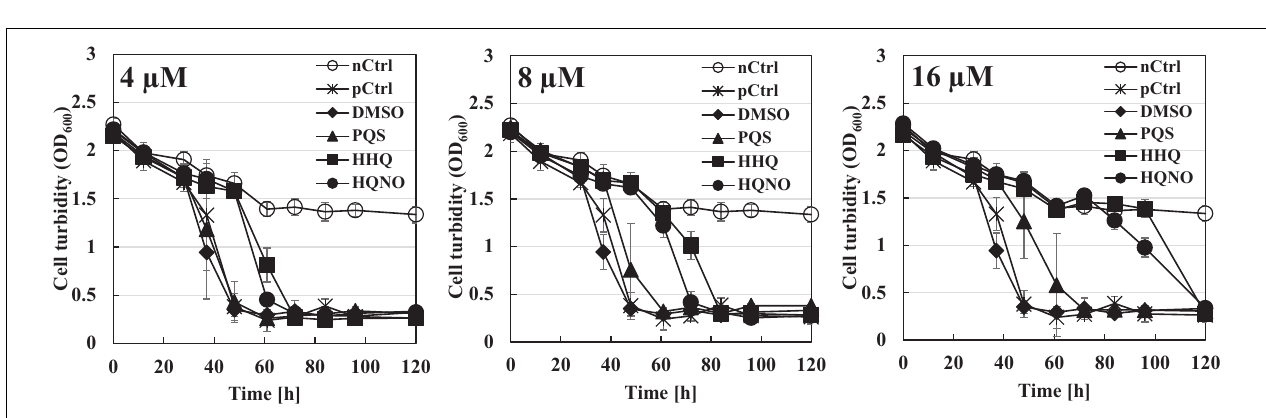
FIGURE 4 | Effect of each quinolone compound itself on the predation liquid assays using a mixture of Bdellovibrio bacteriovorus 109J and Escherichia coli BW25113. Each cell turbidity of E. coli BW25113 (OD 600 nm ∼ 2) was monitored with time after inoculating the cells of B. bacteriovorus under 4 µ M (left) , 8 µ M (middle) , or 16 µ M (right) of each PQS/HHQ/HQNO compound or DMSO which was used as a solvent for the compounds (as the control). “nCtrl” means a sample consisting of only the E. coli BW25113 cells in HEPES buffer without any compound, whereas “pCtrl” means a mixture of E. coli cells and B. bacteriovorus cells in HEPES buffer without any compound. PQS, Pseudomonas quinolone signal, 2-heptyl-3-hydroxy-4(1H)-quinolone; HHQ, 2-heptyl-4-quinolone; HQNO, 2-heptyl-4-quinolinol 1-oxide. n = 3.